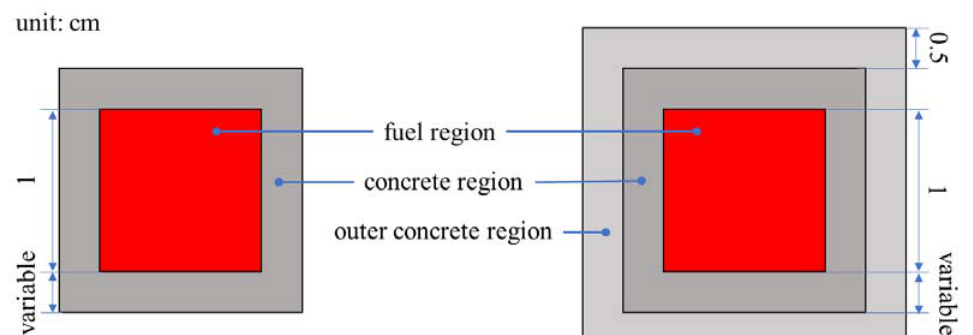
Figure 2. Geometries to calculate the macroscopic cross sections. The left and right geometries were used to calculate (! "# and ! "$ ) and ! "% , respectively.